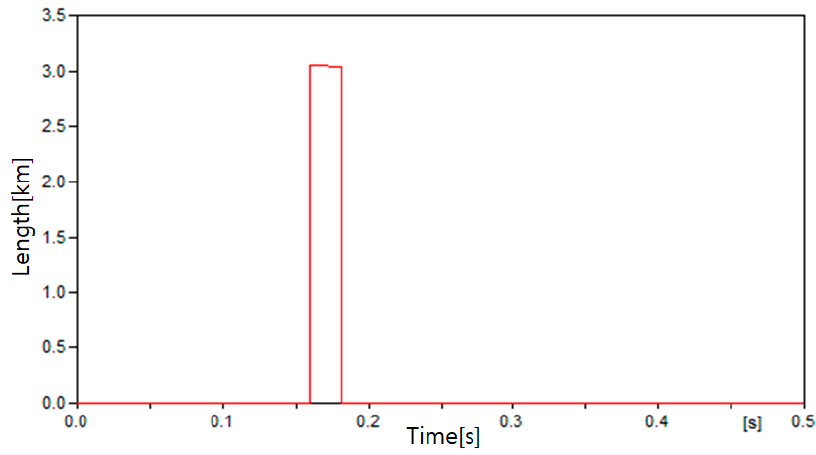
Energies 2020 , 13 , x FOR PEER REVIEW